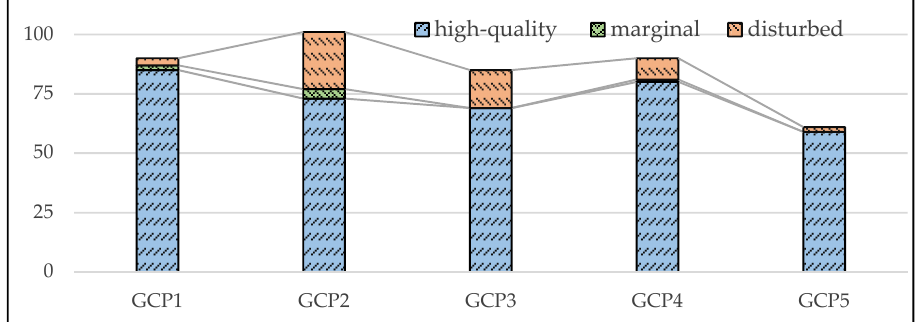
Figure 7. Histogram of the high-quality, marginal, and disturbed ROIs for the five GCPs. Low-quality ROIs tend to cause unexpected results when positioning GCP pixels, so they need to be identified and filtered before carrying out the positioning of GCP pixels.